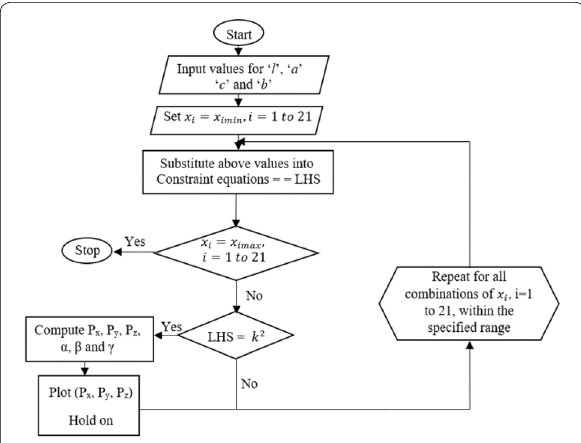
Figure 7 Flow chart for the workspace